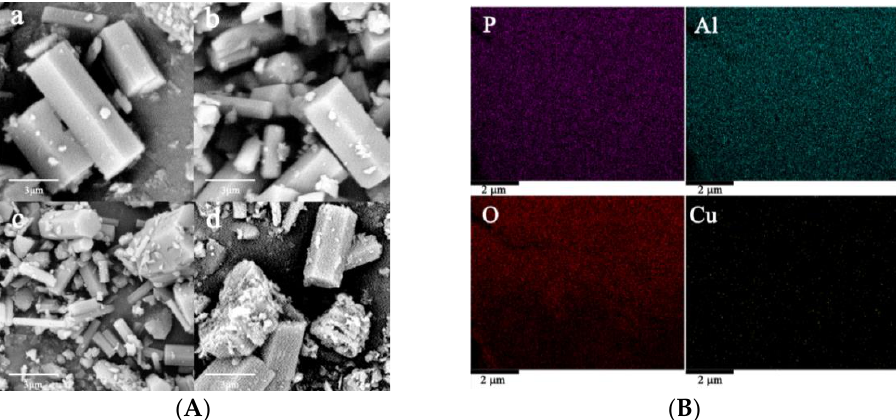
Figure 2. SEM images of a: AlPO4-5, b: CuAPO-5 (0.03), c: CuAPO-5 (0.06), d: CuAPO-5 (0.09) ( A ), and Electron mapping of CuAPO-5(0.06) ( B ).